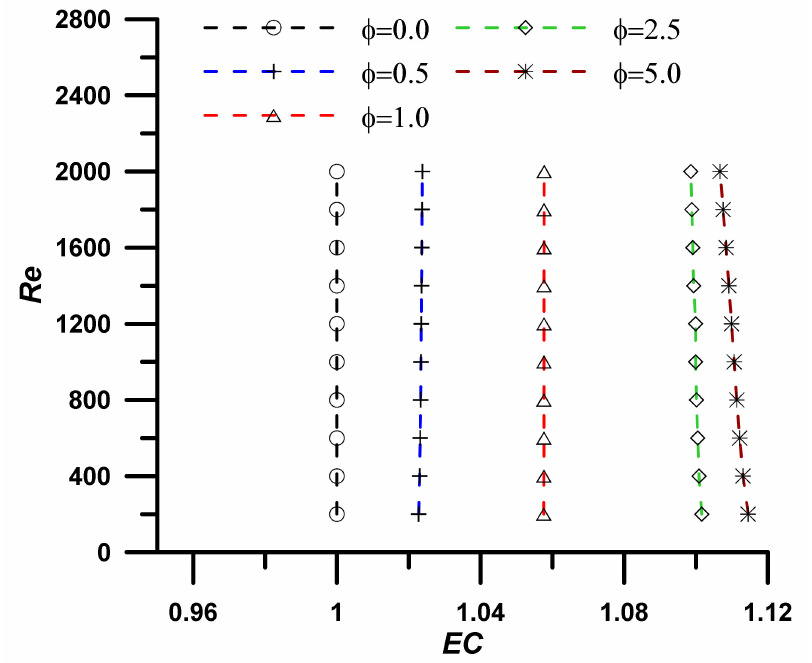
Figure 5. Evaluation performance criteria at T = 303.15 K for investigated nanoparticle concentrations.